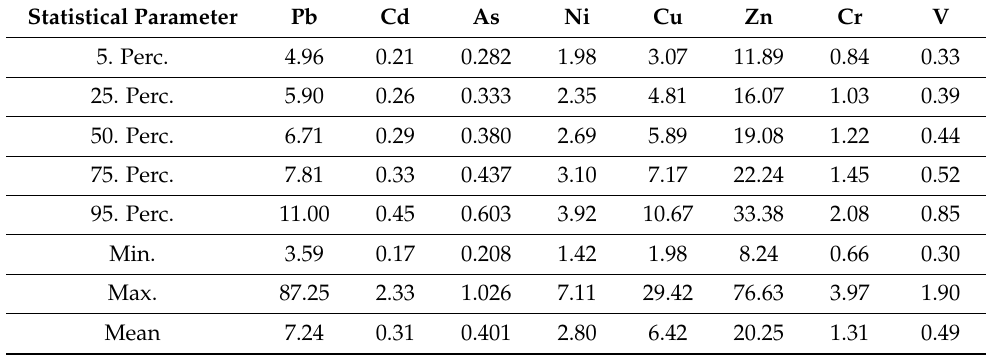
Table 4. Background atmospheric total deposition of heavy metals (g ha − 1 a − 1 ) [18]. Statistical Parameter